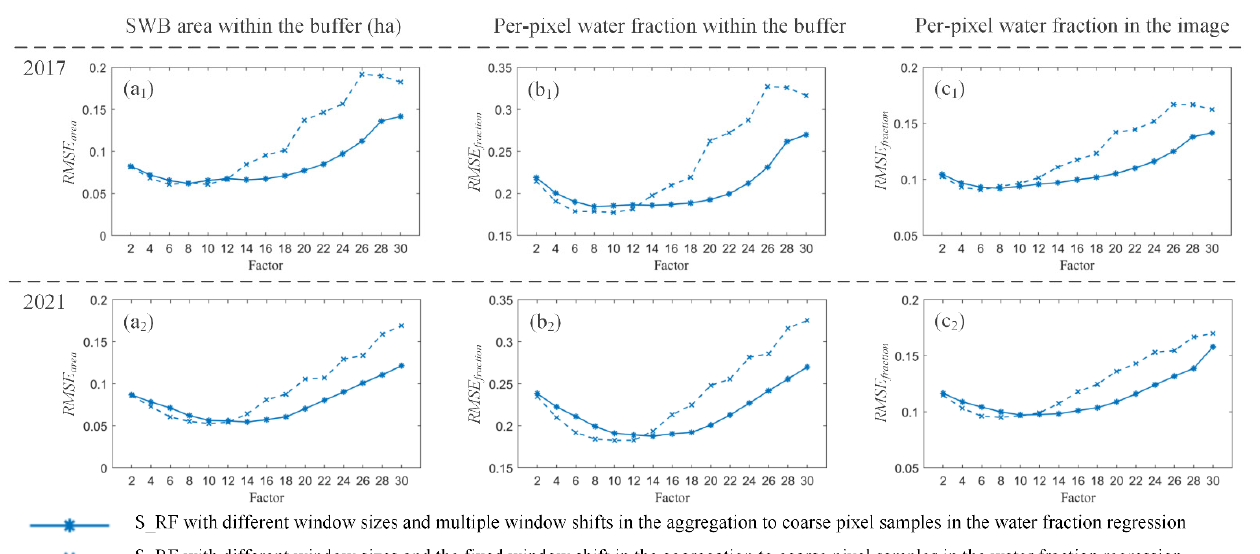
Figure 11. Accuracies in self-trained random forest regression (S_RF) with different window sizes and shifts in the aggregation to coarse pixel samples in the water fraction regression in S_RF. ( a 1 , a 2 ) RMSE area values in the estimation of small water body (SWB) area, ( b 1 , b 2 ) RMSE fraction values in the estimation of SWB fractions in the buffer and ( c 1 , c 2 ) RMSE fraction values in the estimation of SWB fractions in the entire image.